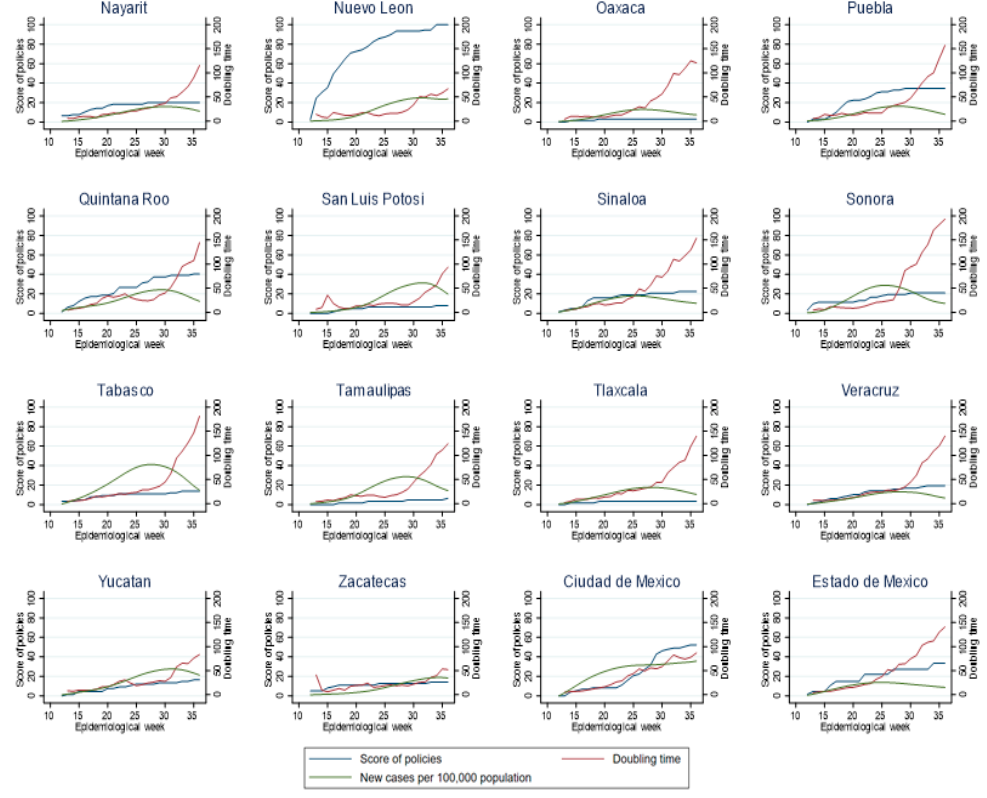
Figure 4. Policy index, new cases, and doubling time by week in states of Mexico (B).